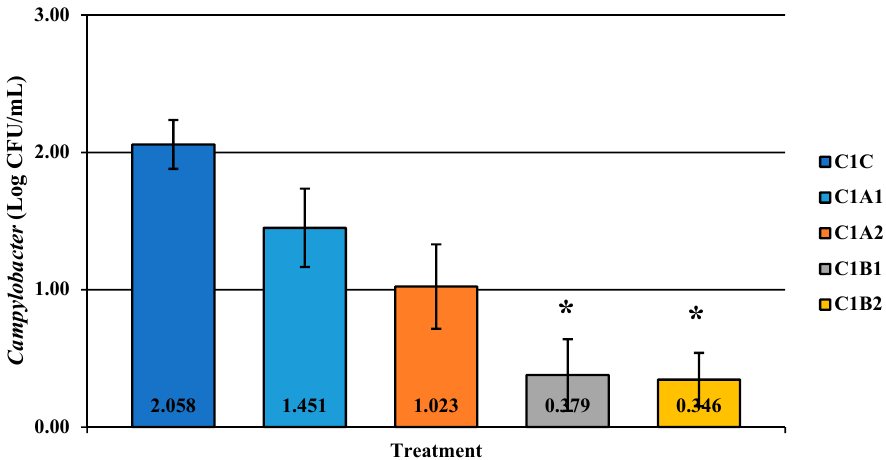
Figure 4. The effect of Competitor 1, a PAA sanitizer used as an antimicrobial dip (400 or 600 ppm) and in a stationary chilling tank (25 or 45 ppm) on the load of Campylobacter present in the rinsates of 42-d-old Ross 708 broilers. The means are numerically stated on the bar graph. N = 50, n = 10, p = 0.0022. CA1 refers to a 400 ppm / 25 ppm treatment, CA2 refers to a 400 ppm / 45 ppm treatment, CB1 refers to a 600 ppm / 25 ppm treatment, and CB2 refers to a 600 ppm / 45 ppm treatment, with each treatment being first a post-evisceration dip followed by an immersion chill.